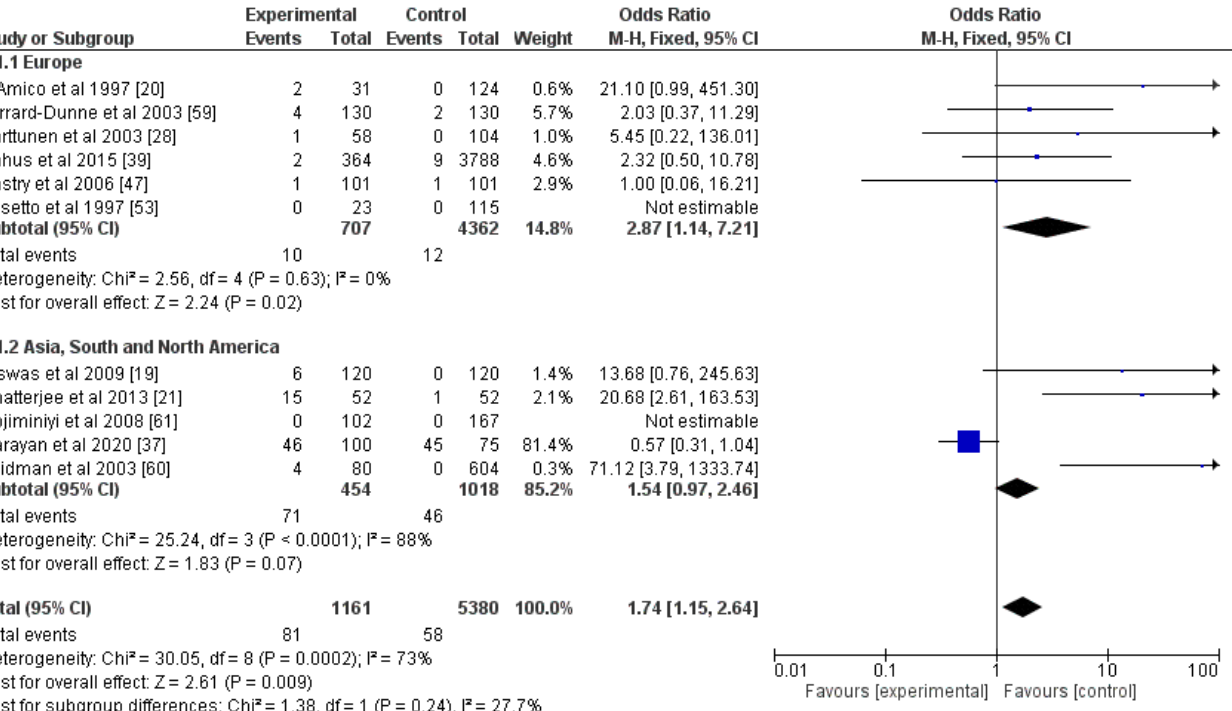
Figure 4. Forest plot for protein C and subgroup analysis based on geographic location of the study. Blue squares indicate odds ratios. Black rhombi indicate overall effect. Vertical line indicates null effect, and horizontal lines indicate values of odds ratios.